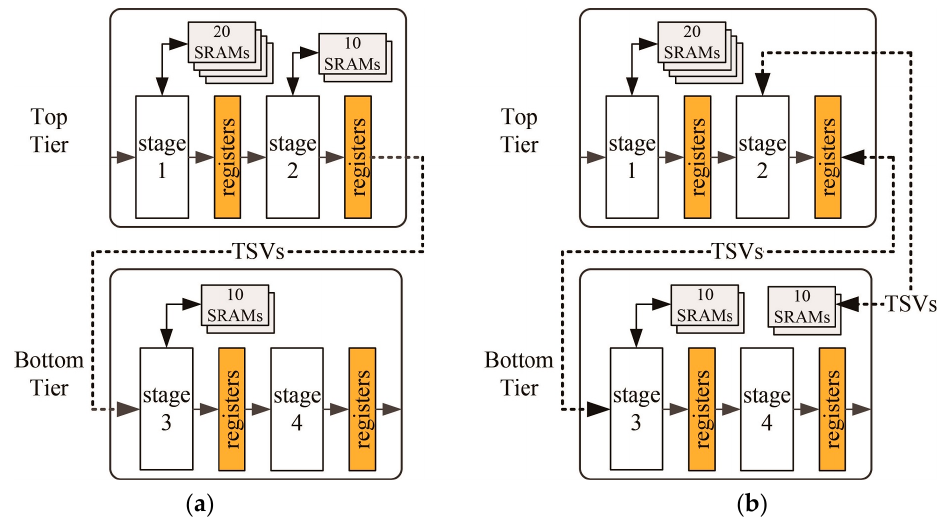
Figure 8. An illustration of the proposed pipeline-level partitioning method: ( a ) Split the pipeline stages into two tiers, and ( b ) adjust the number of SRAMs in each tier.